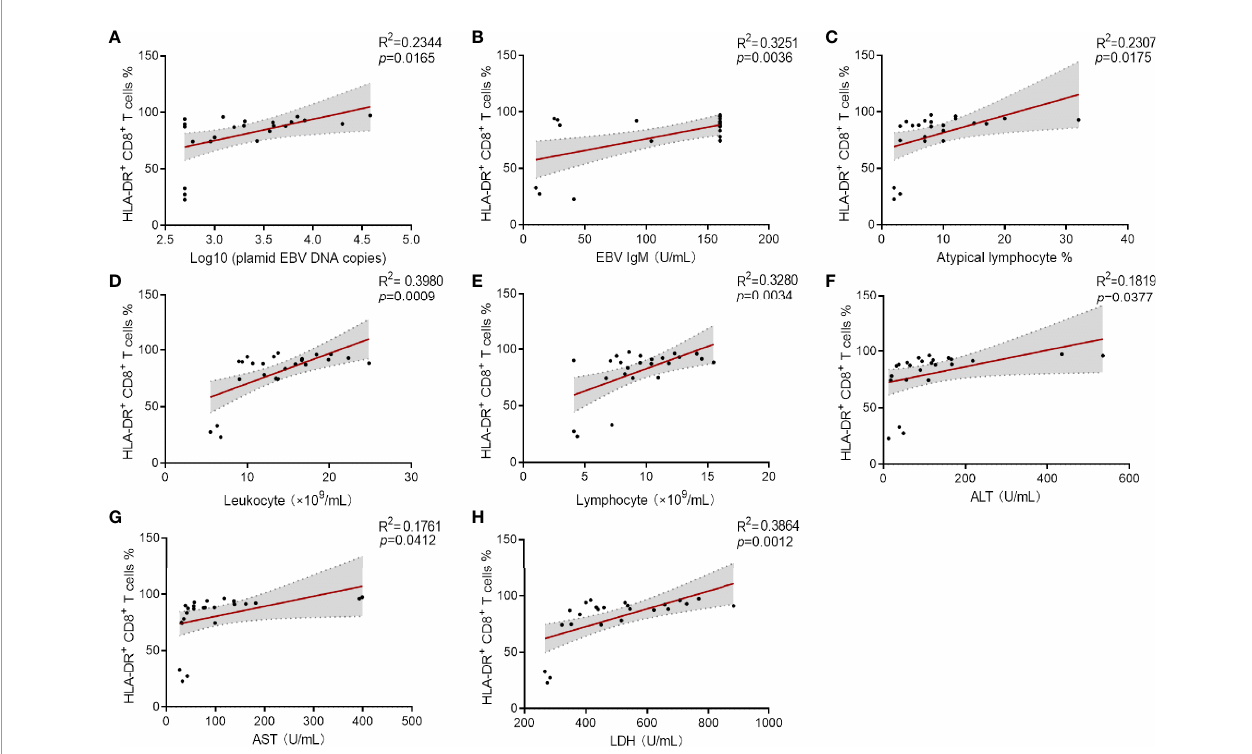
FIGURE 6 | Correlation analysis between the percentage of HLA-DR + CD8 + T cells and viral loaders and laboratory results. (A – C) Correlation between the percentage HLA-DR + CD8 + T cells and plasmid EBV DNA copies (data were log10 transformed), EBV IgM levels and the percentage of atypical lymphocytes in peripheral blood smear. (D, E) Correlation between the percentages of HLA-DR + CD8 + T cells and the counts of leukocytes and lymphocytes were shown. (F – H) Correlation between the percentages HLA-DR + CD8 + T cells and the levels of ALT, AST, and LDH were shown. ALT, alanine aminotransferase; AST, aspartate aminotransferase; LDH, lactate